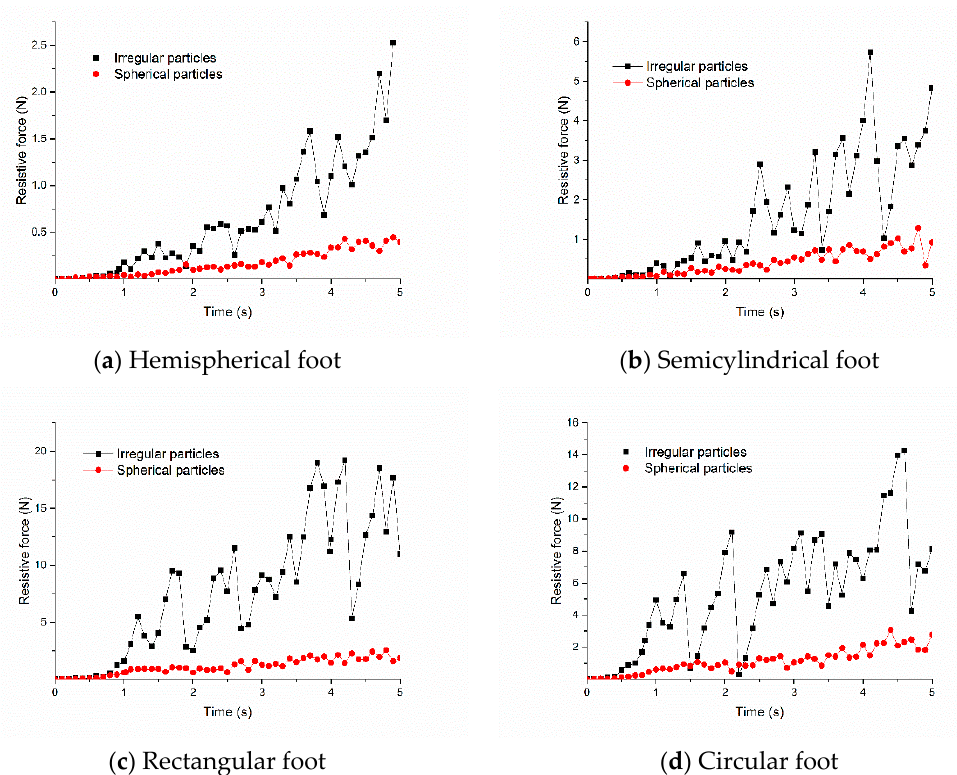
Figure 13. The effect of particle shape on the foot intrusion resistive force. Figure 13. The e ff ect of particle shape on the foot intrusion resistive force.